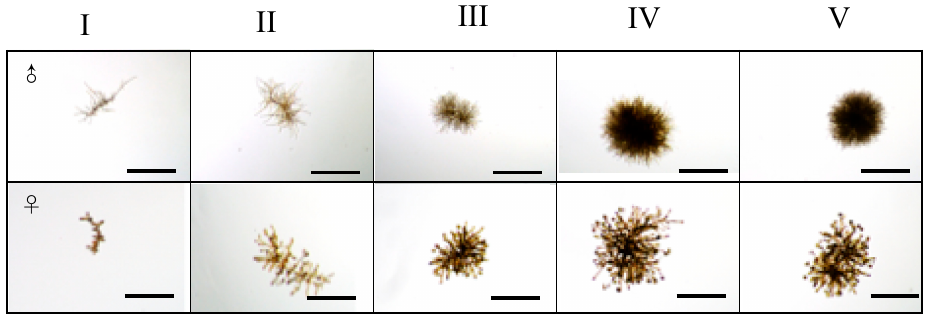
Figure 2. Illustrating the maturity scales for male and female gametophytes, from I (immature) to V (fully mature). Scale bars 500 µm.